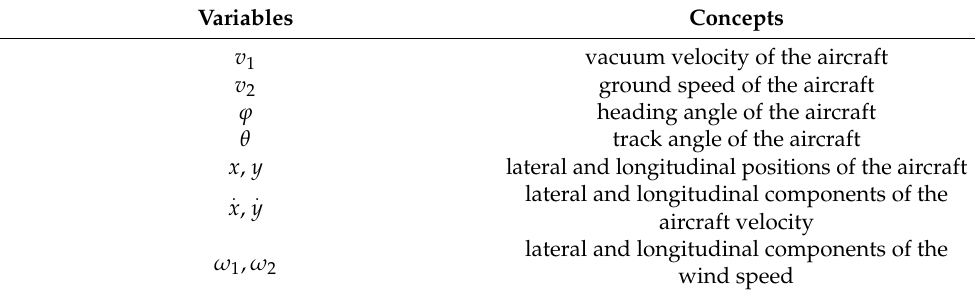
Table 2. Variables and corresponding concepts of kinematic equation of the aircraft. Variables